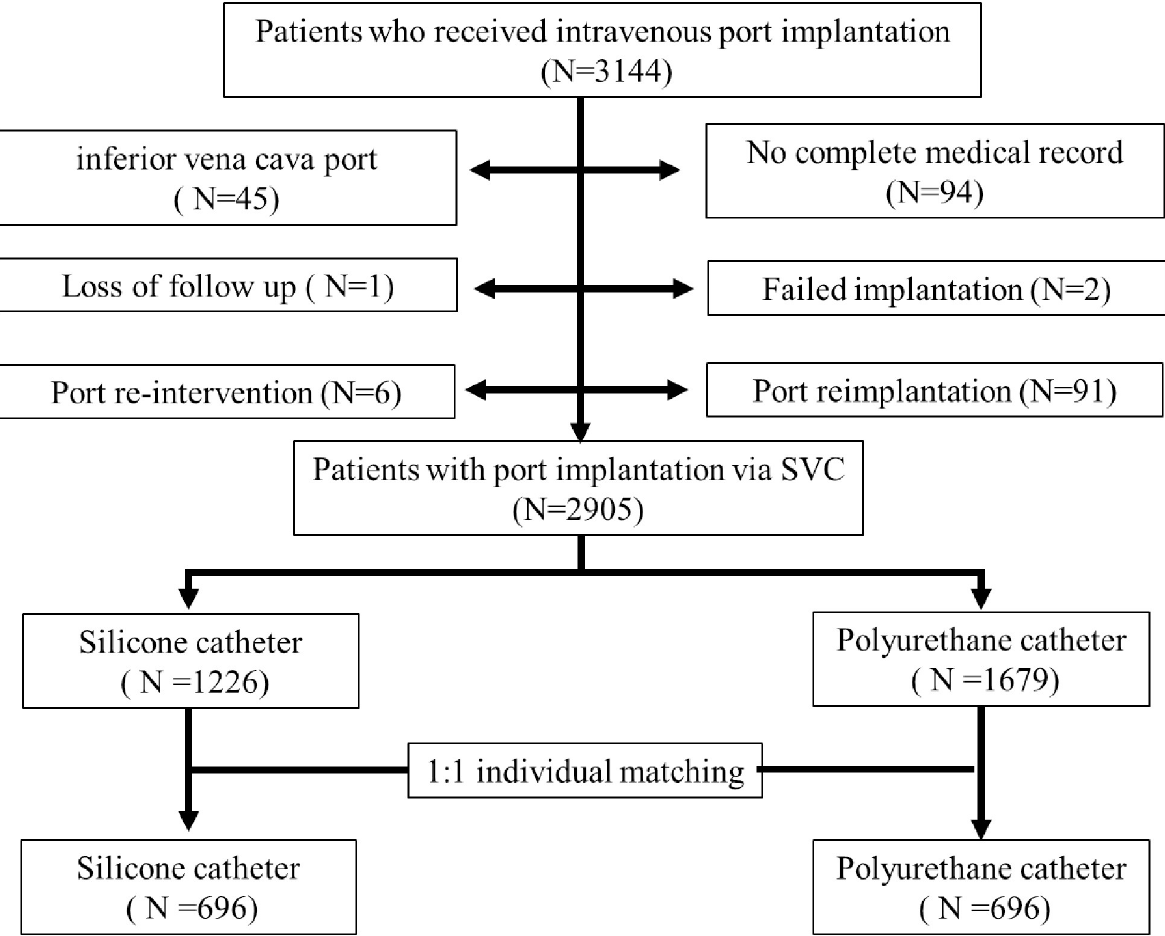
Fig 1. Patients’ disposition diagram. Paired variables: Gender, age ± 1, BMI ± 1, Underlying malignancy (Head and neck, Thorax, Abdomen, Pelvis, Soft tissue, Hematology and Other).